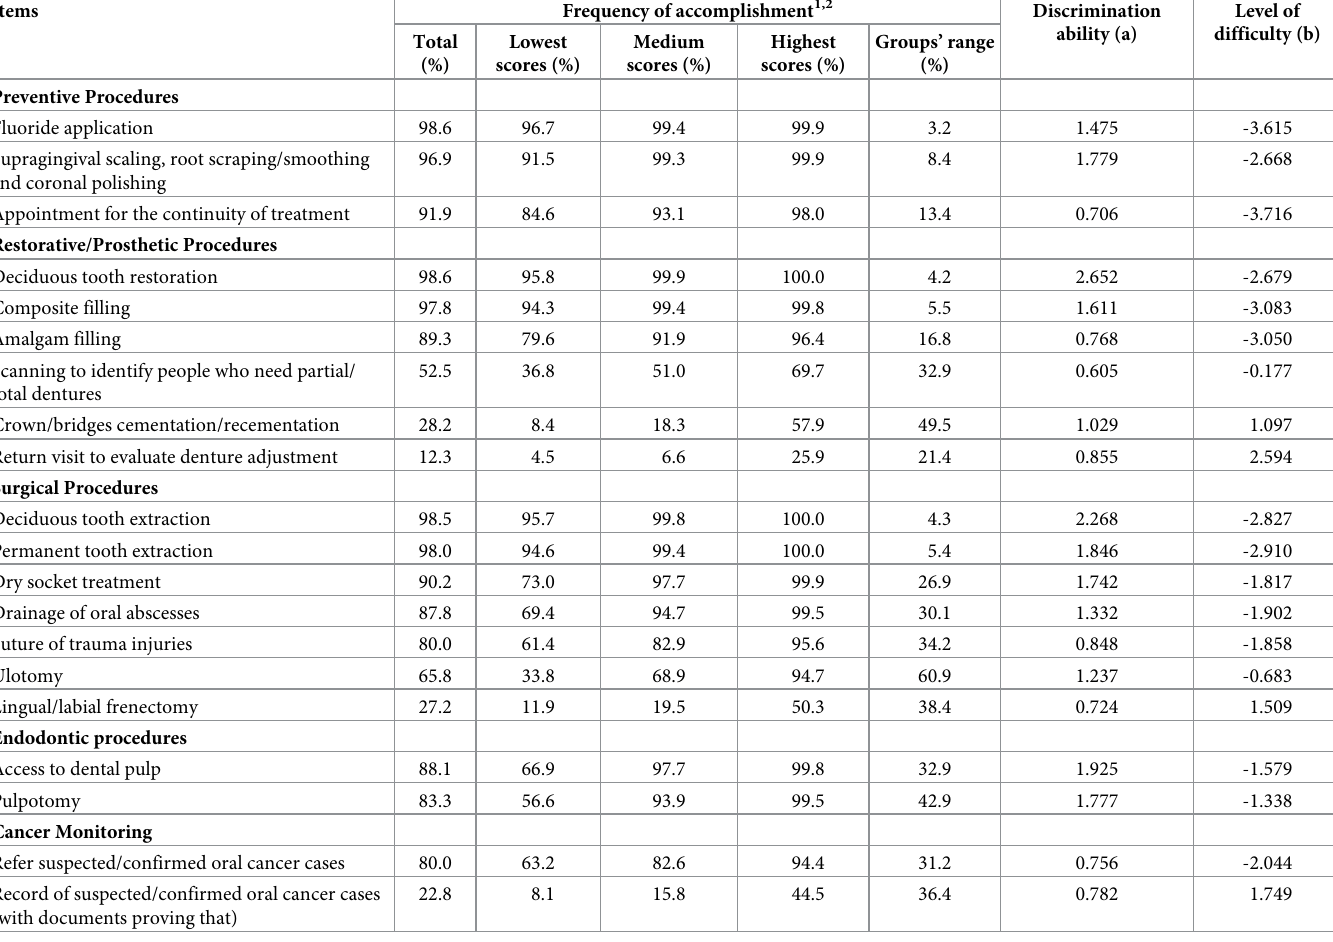
Table 1. Performance of each item provided in primary dental care: Total and categorized in groups of dental teams with the lowest, medium and highest scores; group’s frequency range; (a) discrimination parameter; and (b) reported difficulty level, Brazil,